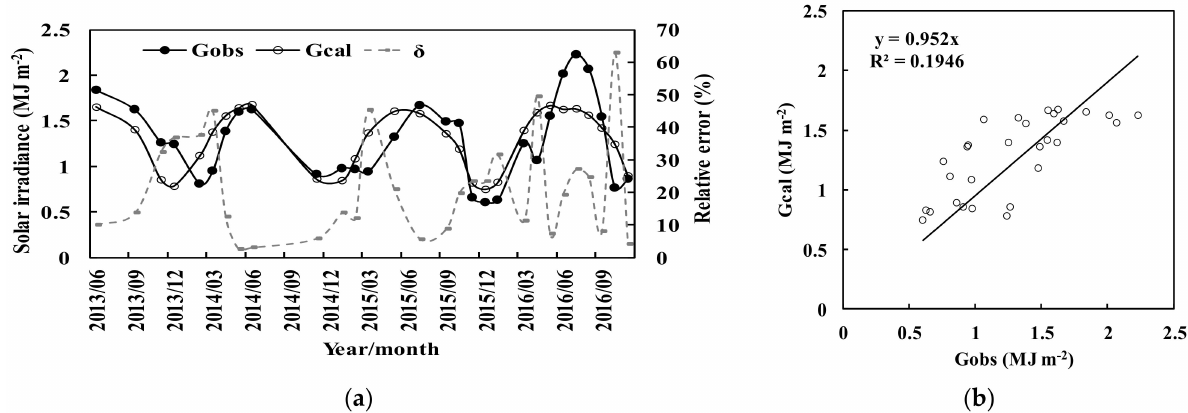
Figure 2. ( a ) Time series of monthly mean calculated and observed global horizontal solar irradiances (G cal and G obs ) and their relative errors ( δ ) for atmospheric conditions with S/G ≥ 0.8. ( b ) Scatter plot of calculated versus observed solar irradiance (G cal and G obs ) for atmospheric conditions with S/G ≥ 0.80. The regression parameters in the legend were obtained for a fit forced through zero.